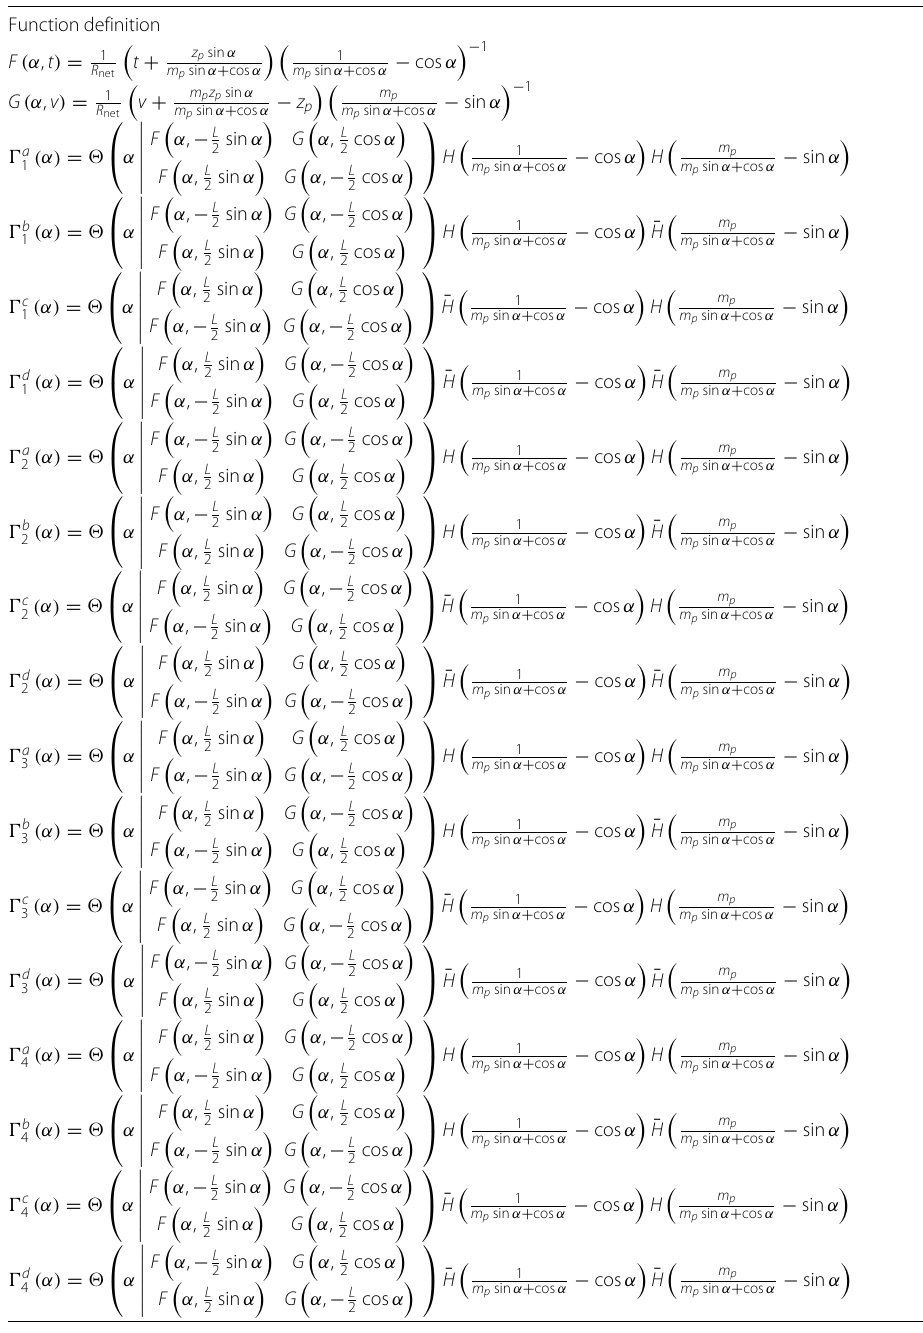
Table 3 Auxiliary functions used in Proposition